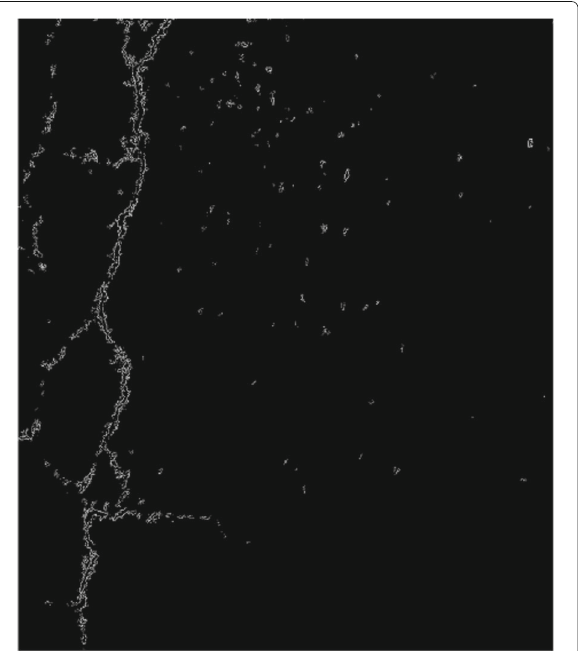
Fig. 5 Result of applying the bilateral filter to Fig. 4. After a bilateral Fig. 6 Result of applying the Canny edge detector algorithm to Fig. 5. The crack is now clearly identified